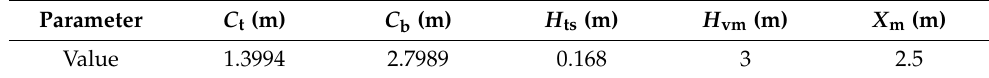
Table 1. Parameters of the vertical tail.